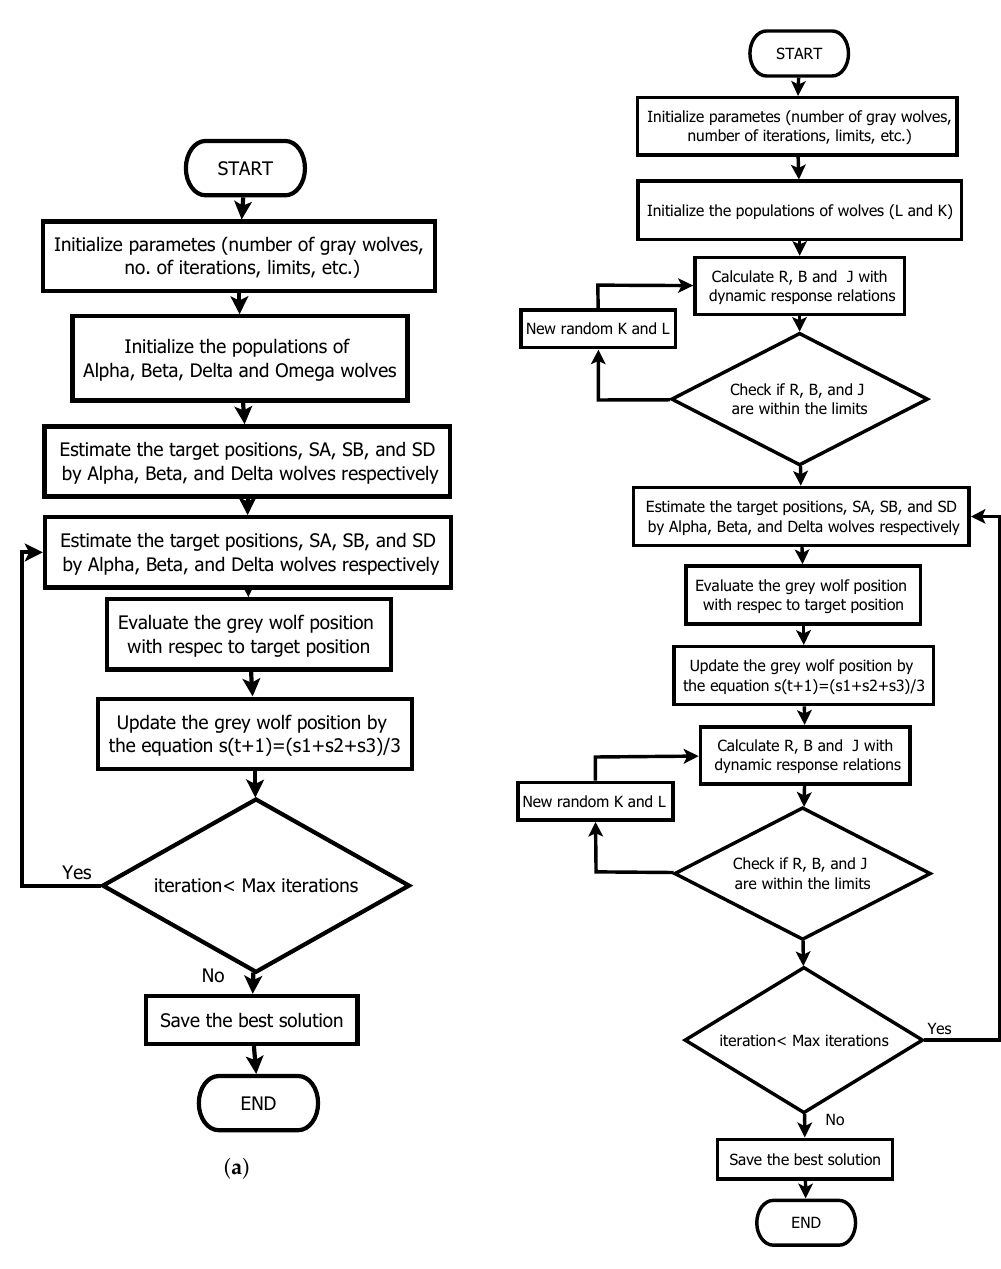
Figure 3. Grey Wolf Optimizer. ( a ) Original Algorithm; ( b ) Modified algorithm with dynamics